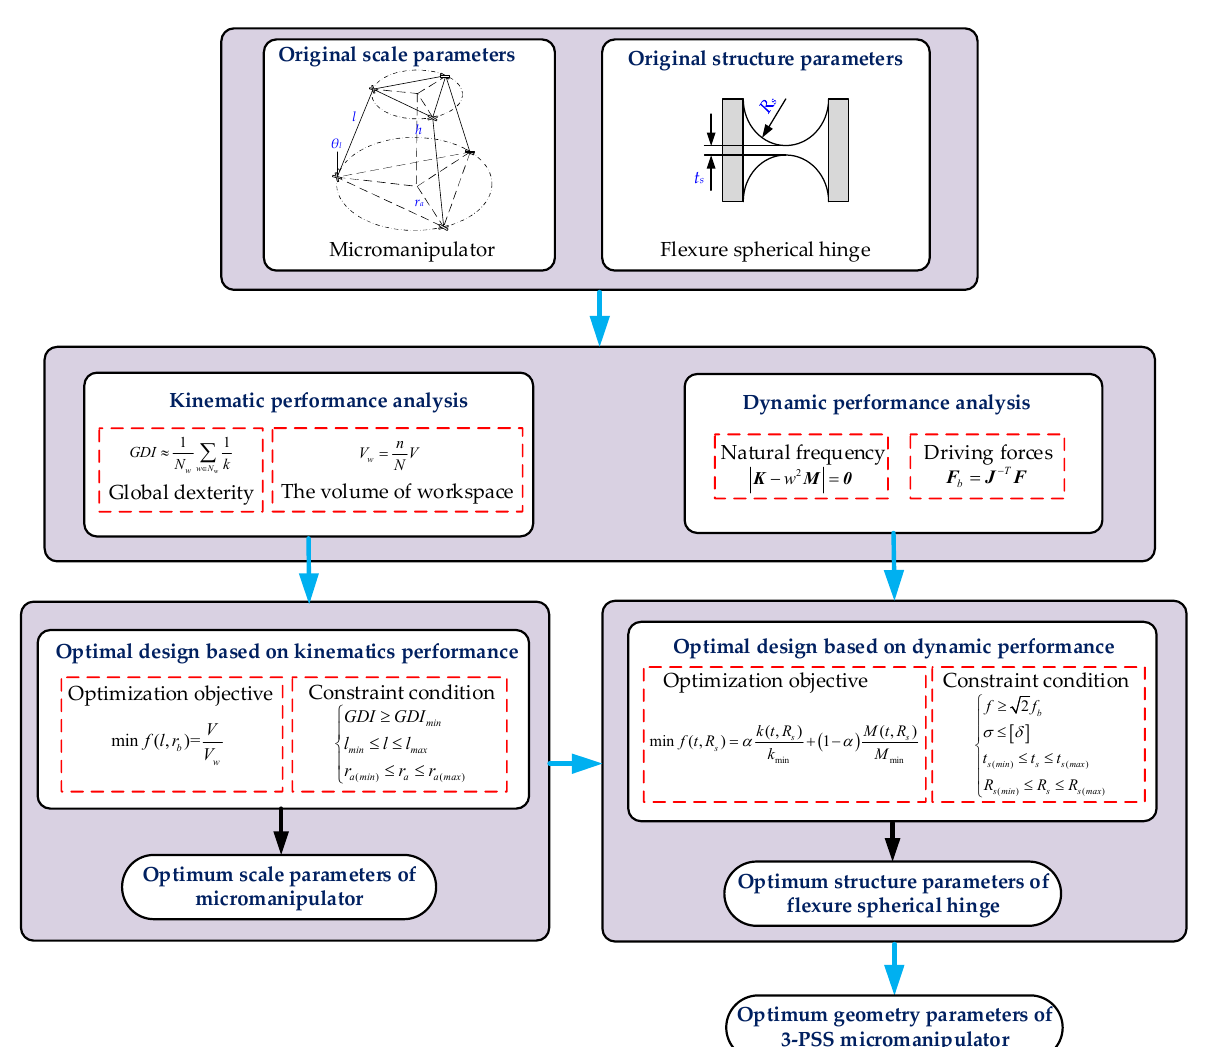
Figure 9. The progressive optimization procedure for analyzing and designing 3-PSS flexible parallel micromanipulator.